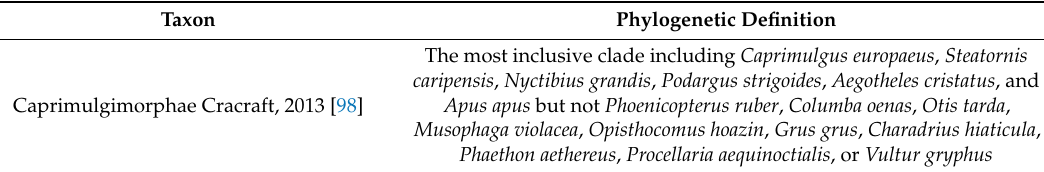
Table A1. This appendix lists higher-order taxon names that have been applied to Strisores and proposed phylogenetic definitions. All definitions are newly proposed by this study unless otherwise